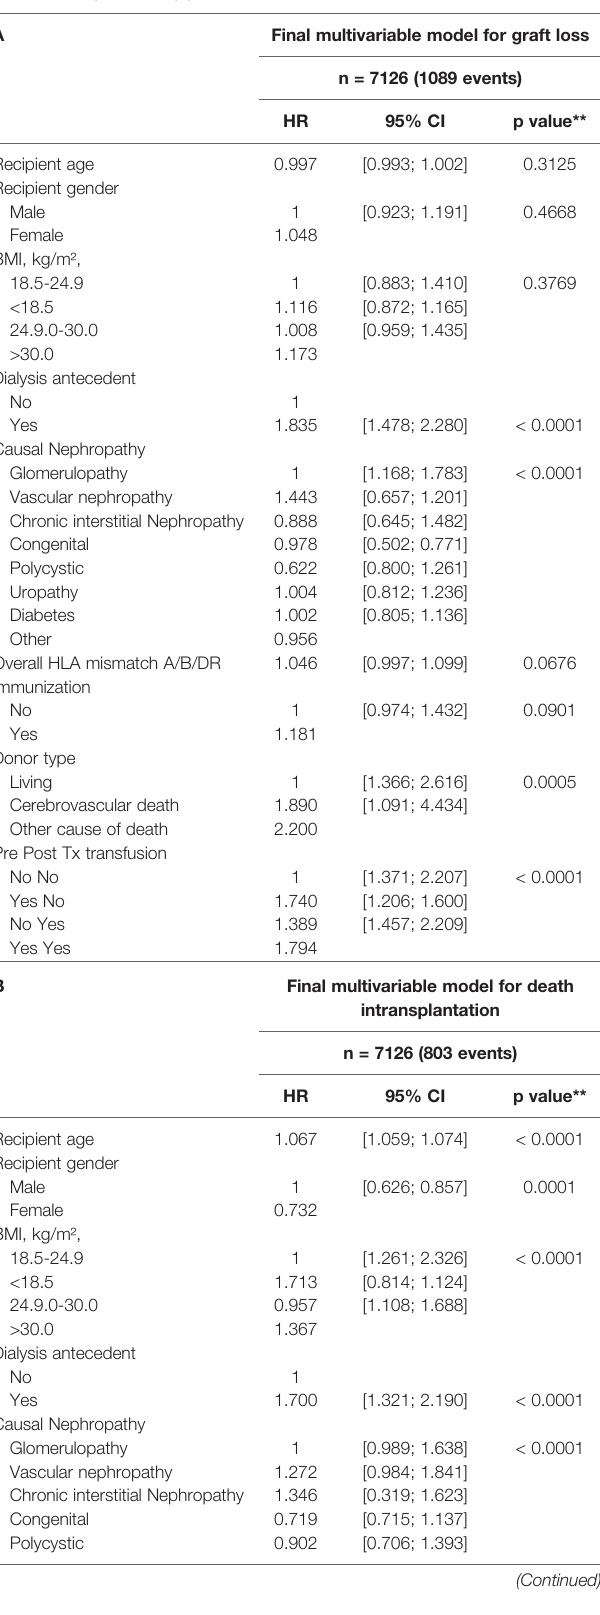
TABLE 3 | Multivariable analysis of parameters associated with graft loss (A) or death in transplantation